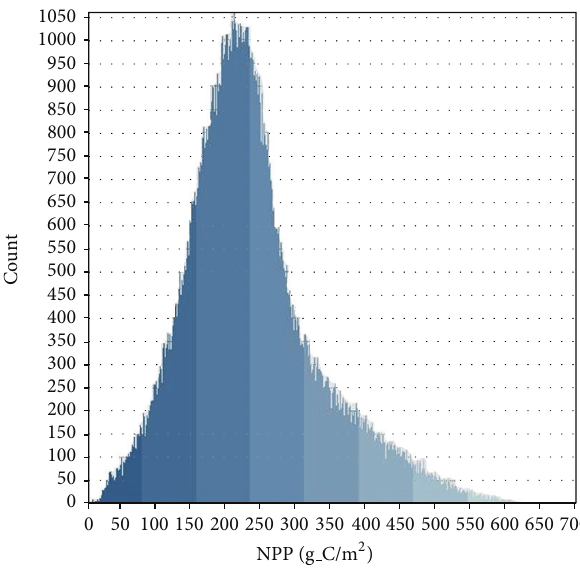
Figure 1: Histogram of Sichuan grassland NPP.